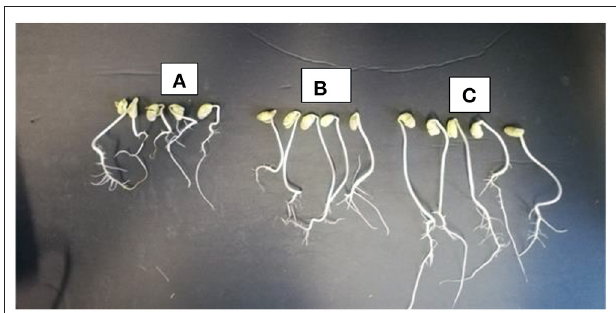
FIGURE 1 | Radicle length of soybean seedlings treated with 0mM NaCl (A) , 0mM NaCl + 0.20% M13 (B) , and 0mM NaCl + 0.2% BA (C) .